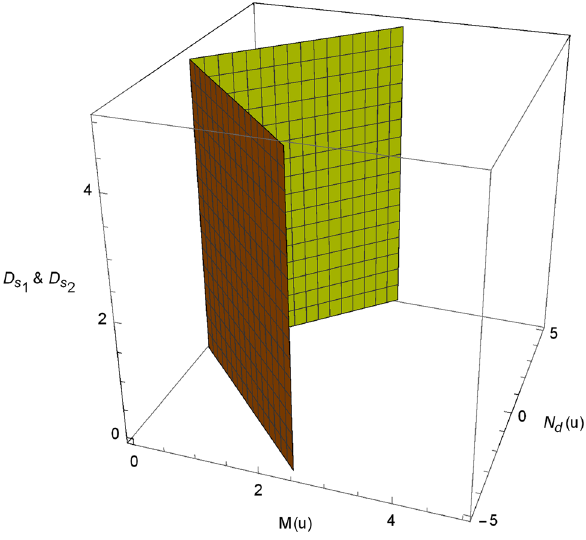
Fig. 4 The variation of D s and N d ( u ) parameters for the dust